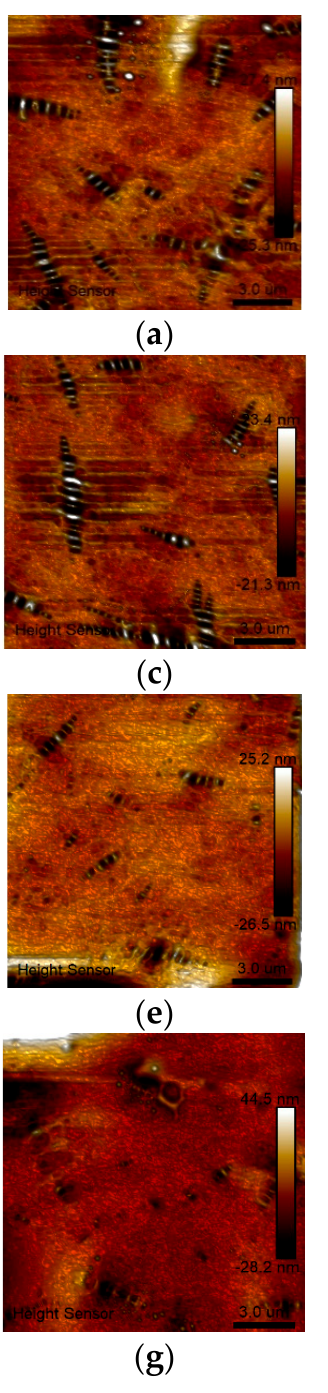
Figure 9. Topography maps of different samples: ( a ) 2D topography (A1); ( b ) 3D topography (A1); ( c ) 2D topography (A2); ( d ) 3D topography (A2); ( e ) 2D topography (A3); ( f ) 3D topography (A3); ( g ) 2D topography (A4); ( h ) 3D topography (A4).